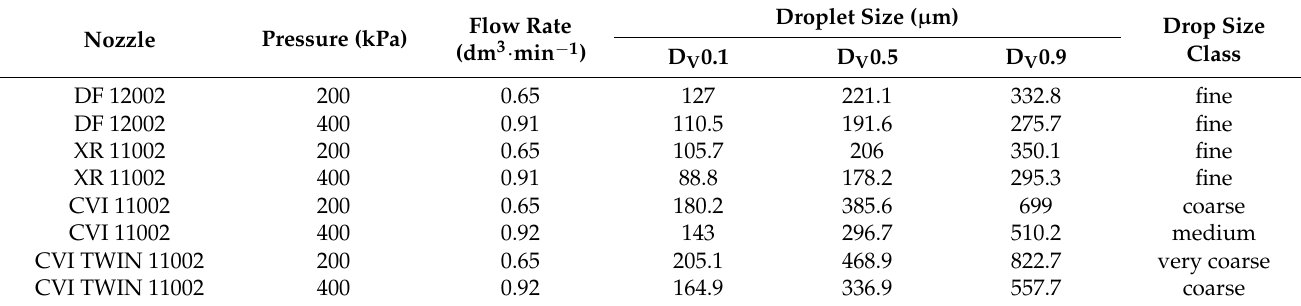
Table 1. Characteristics of selected nozzles.